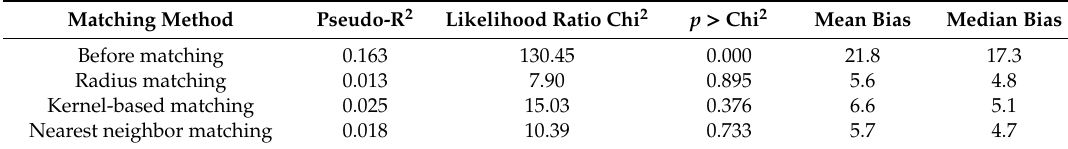
Table 4. Balancing test justifying matching.